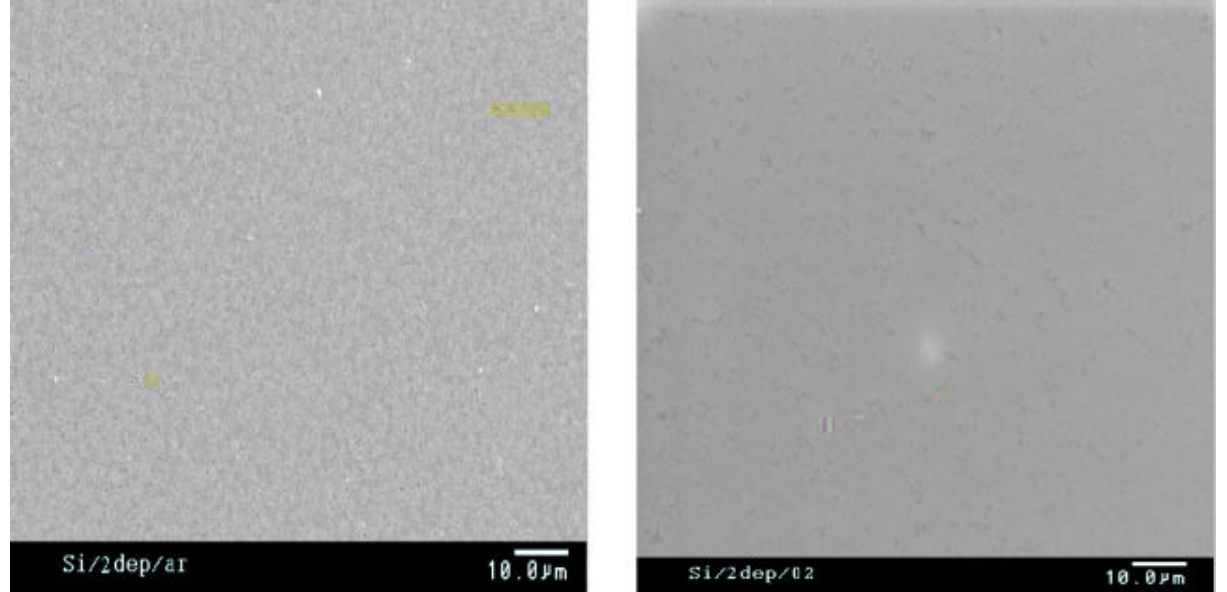
Figure 3. SEM micrographs of PLZT film surfaces ( η = 40 cP) deposited on Si (100) substrate with speed of 5 mm/min, heating rate of 5 °C/min and annealed at 650 °C for 3 h at differents atmospheres: (a) air and (b)